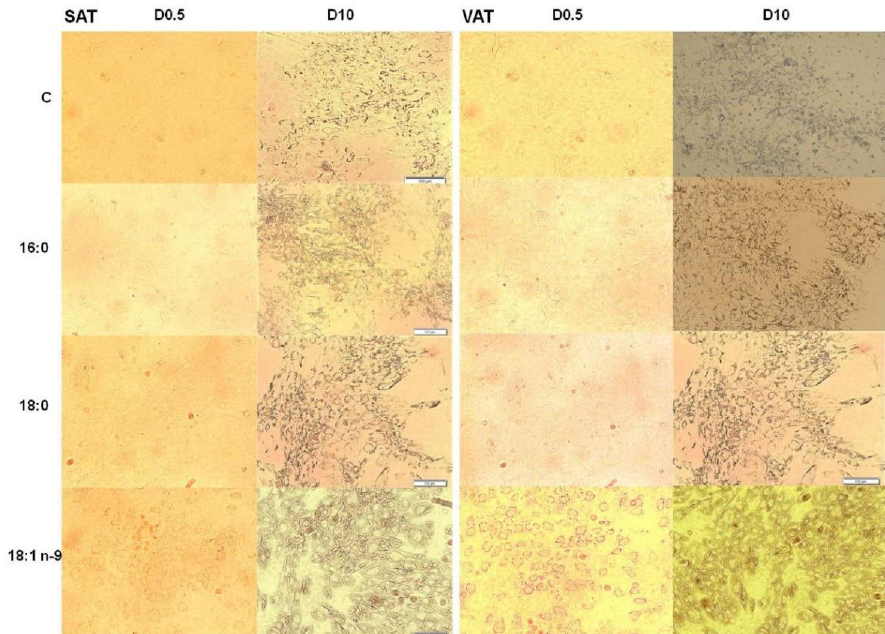
Figure 1. Mesenchymal stem cells (MSCs) collected from subcutaneous adipose tissue (SAT) and visceral adipose tissue (VAT) during adipogenesis. Subcutaneous (left panel), visceral (right panel): D0.5 after differentiation induction and D10 after differentiation induction—fully mature adipocytes differentiated with the excess of palmitic acid (16:0), stearic acid (18:0), oleic acid (18:1n−9), and control cells (C).